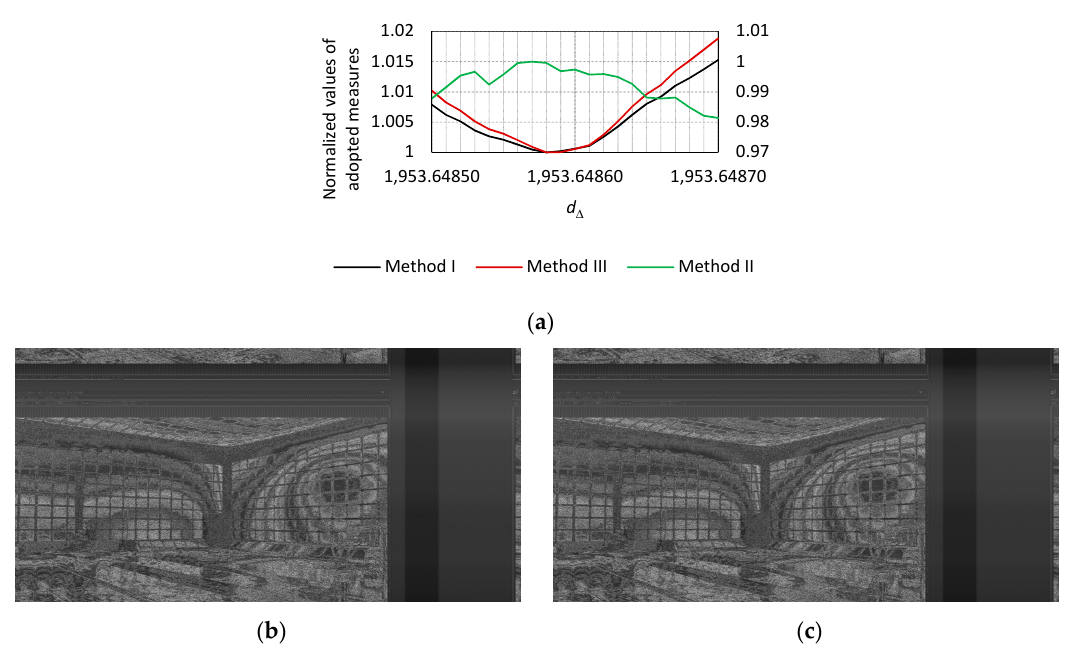
Figure 20. ( a ) The normalized values of the adopted measures (method I, II and III) calculated in domain of image line length d ∆ for the accuracy ∆ = 0.00001 (for the original image shown in Figure 7b) and images reconstructed on the basis of the recorded revealing emission signals at fre- quency f o = 1334 MHz (receiving bandwidth BW = 50 MHz, accuracy ∆ = 0.00001), ( b ) for estimated line length d ∆ = 1953.64857 and ( c ) for estimated line length d ∆ = 1953.64858 —multiple of image summation Sum MTL = 30, the source of revealing signal emission—display monitor, HDMI